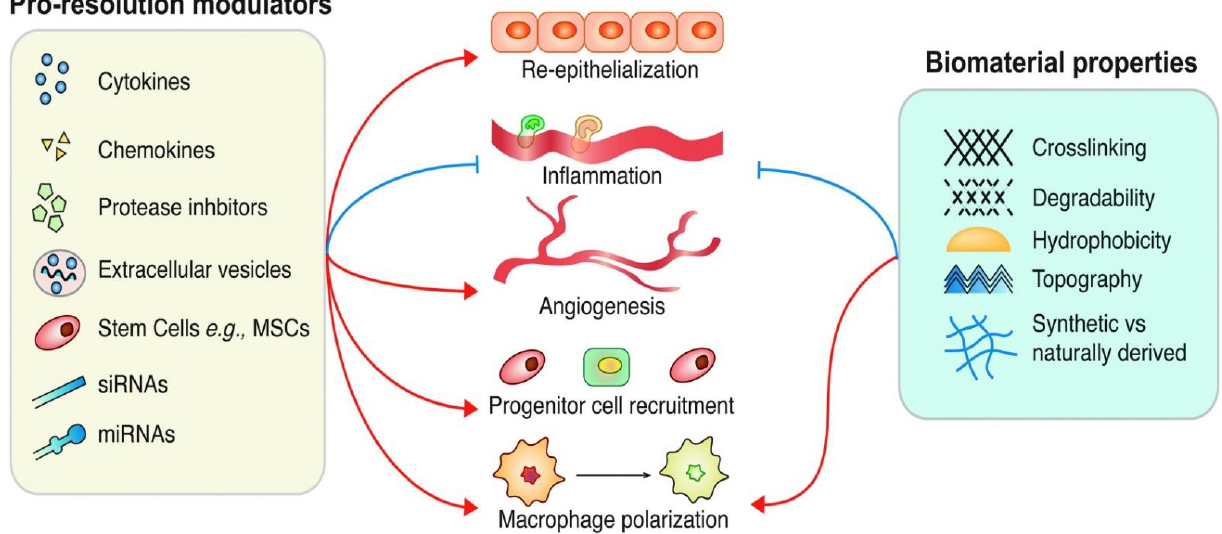
Figure 1. Therapeutic strategies target: Red-acceleration, Blue-Inhibition. Reproduced from Wilgus TA. Immune cells in the healing skin wound: influential players at each stage of repair. Pharmacol. Res. 2008; 58:112–116. and Tan J, Wu J. Current progress in understanding the molecular pathogenesis of burn scar contracture. Burns Trauma 2017; 5:14.